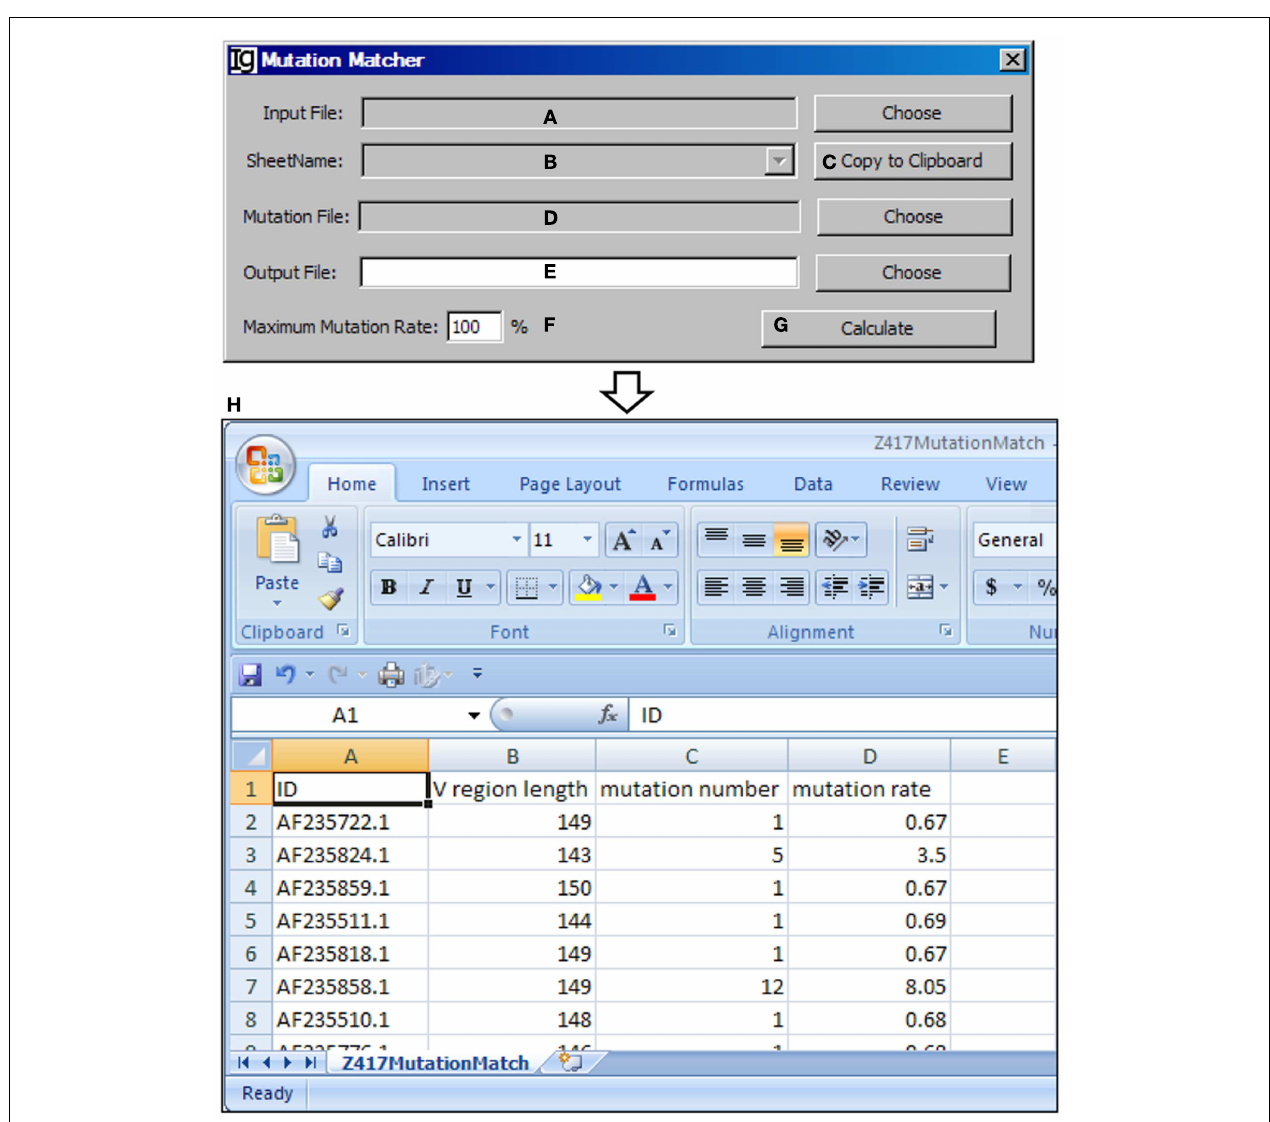
mutation analysis result file from the Mutation Analyzer. (E) Button to choose the output file. (F) Textbox to set the maximum allowed mutation rate in the V H region. (G) Button to start the matching process. (H) The result file of the Z417 test sequences in Excel